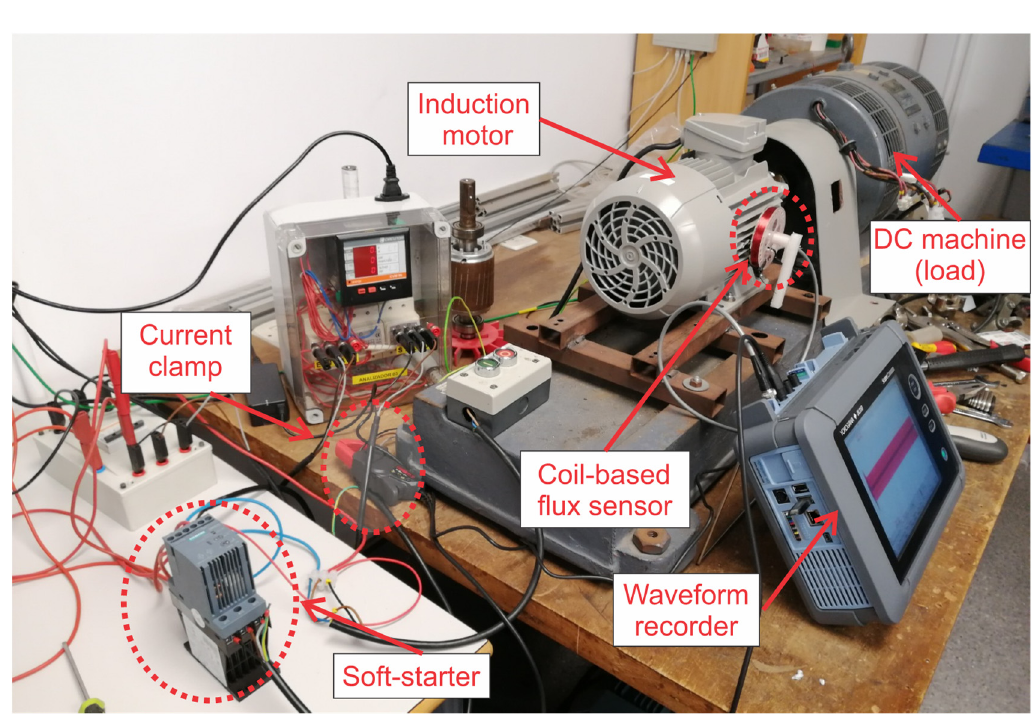
Figure 6. Experimental testbench.